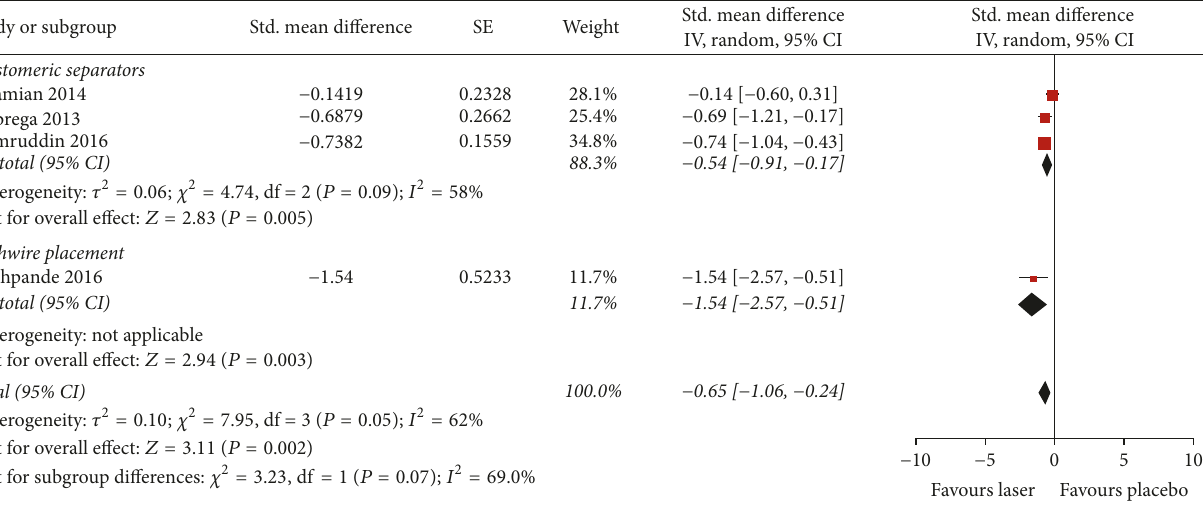
Figure 4: Forest plot of pooled standard mean difference in spontaneous pain at 72 hours.